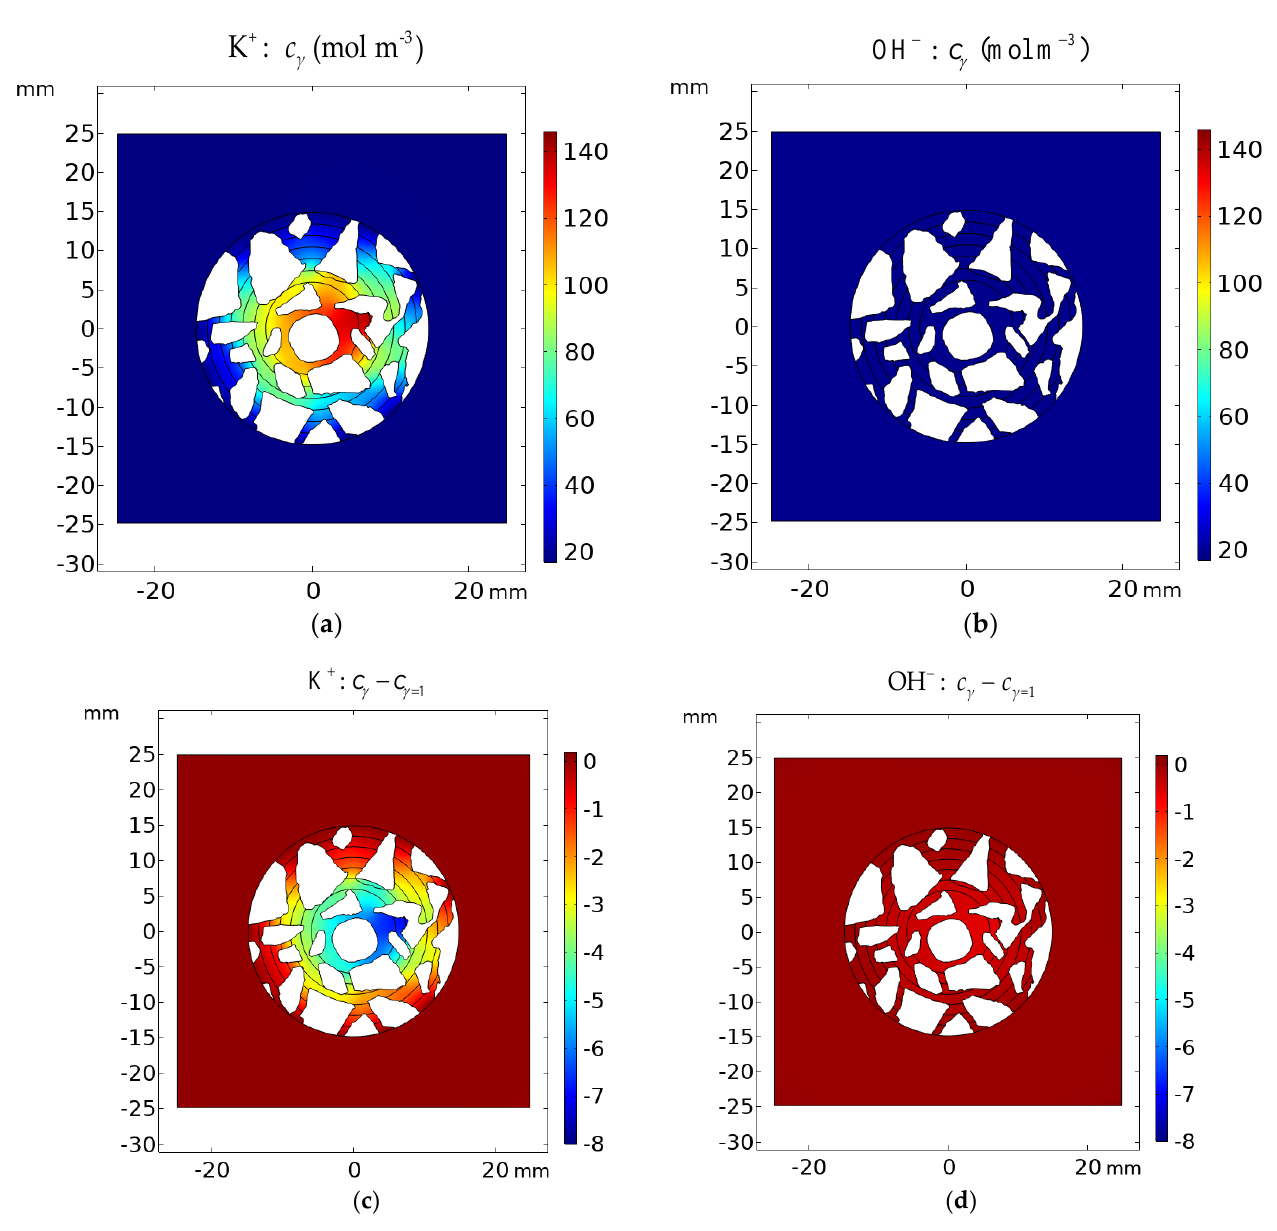
− in the cement sample after